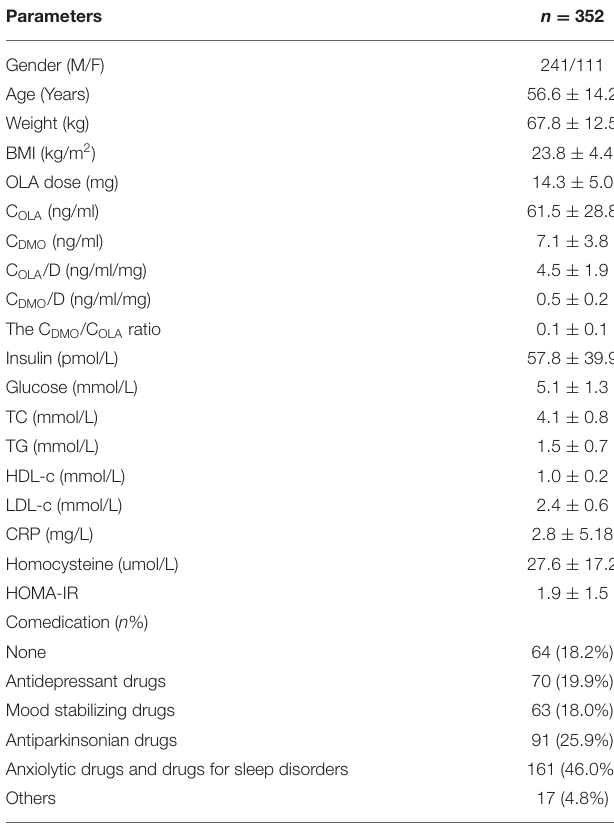
TABLE 1 | Demographic and metabolic characteristics of study